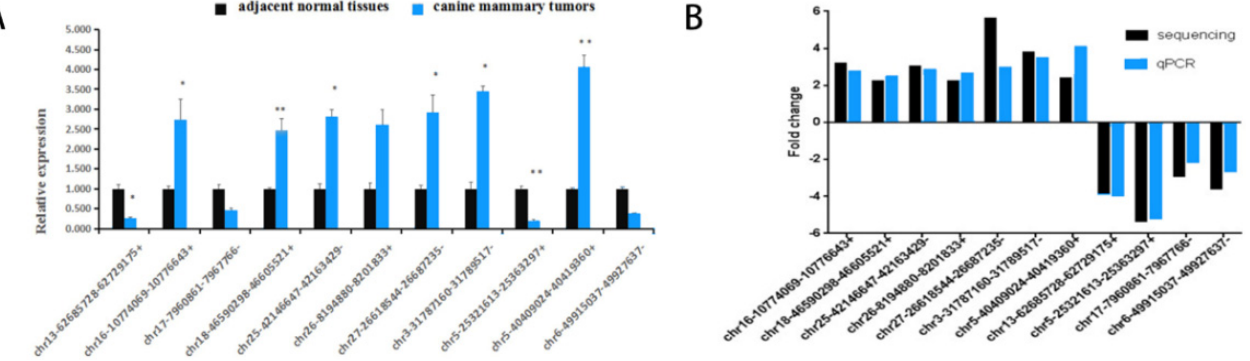
Figure 6. ( A ) Relative expression as indicated by RT-qPCR (11 circRNAs). * p < 0.05, ** p < 0.01; ( B ) fold change detected using sequencing and qPCR. ( B ) fold change detected using sequencing and